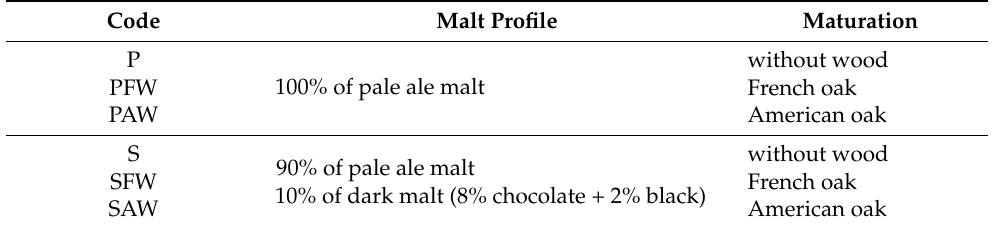
Table 1. Sample codes of beer produced and respective malt profiles and maturation